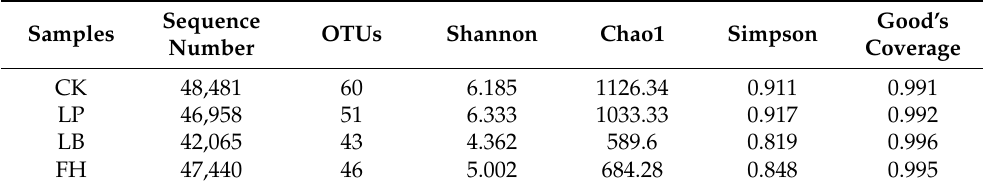
Table 1. Alpha diversity of bacteria in M. aquaticum silage after 60 days of ensiling. Samples